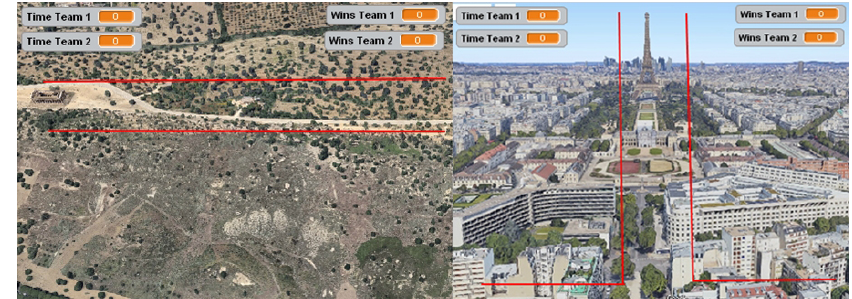
Fig. 5. The robotics track game with highlighted task routes. On the left, the Valley dei Tempi in Sicily and on the right the track in